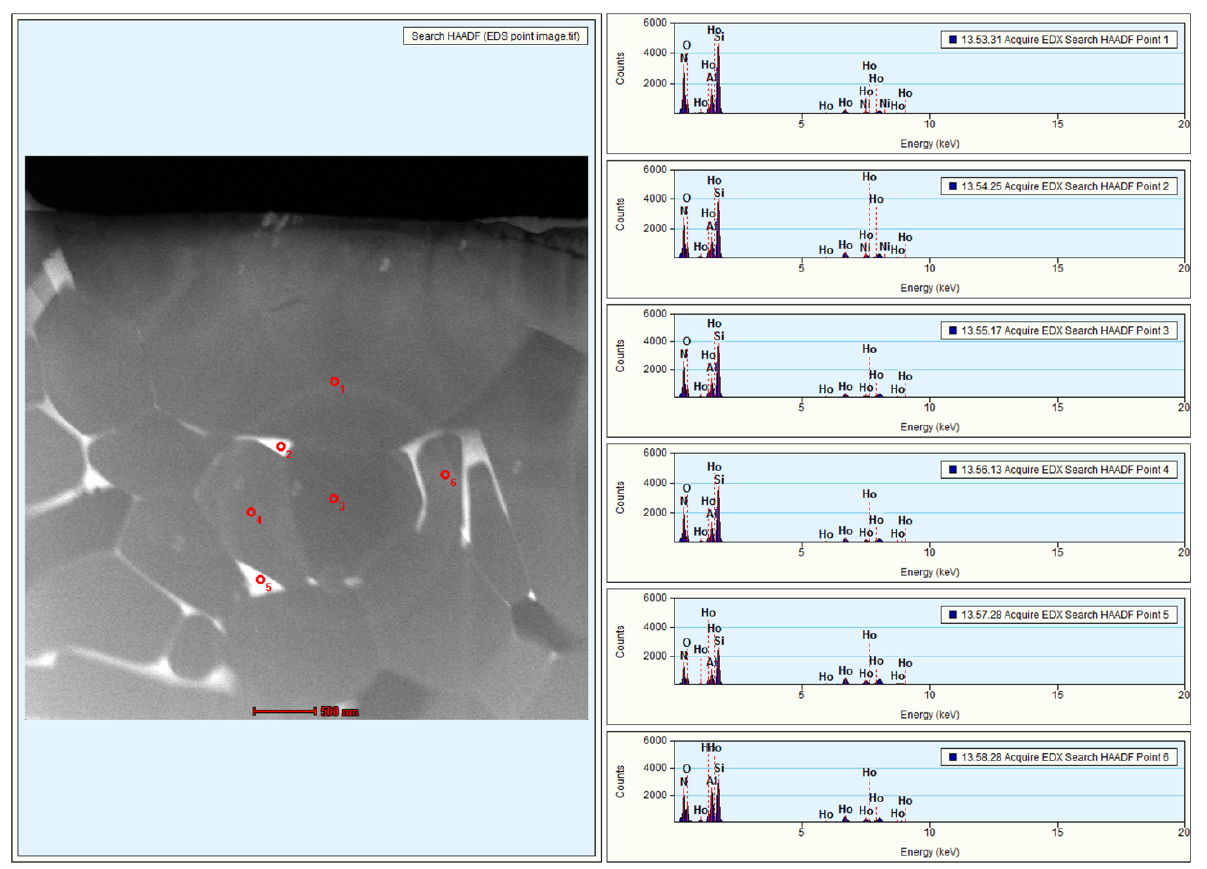
Figure 3. TEM micrograph of H15 sample ( left ) and quantitative EDS spectra ( right ) of the points indicated in the TEM micrograph on the left. Points 1, 3, 4, and 6 correspond to inside the grains, and points 2 and 5 correspond to the triple junctions, respectively.